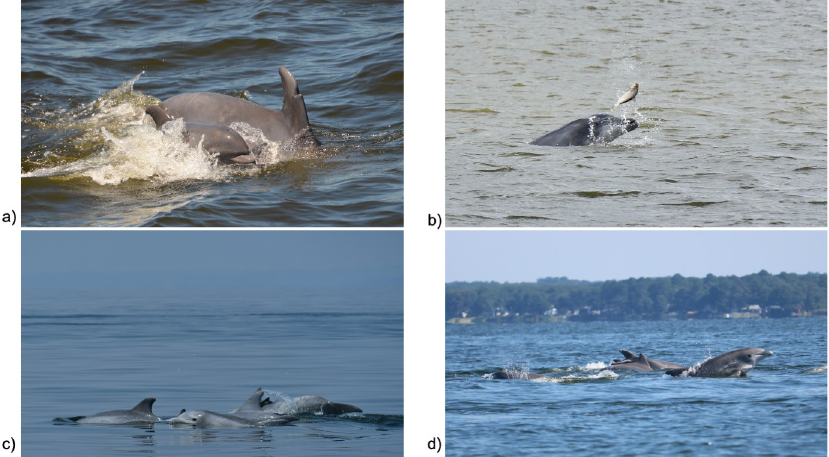
Fig 2. Images submitted into the Chesapeake DolphinWatch application by citizen scientists. a) Photo taken by Toni Knisley of dolphin pod swimming in the Patuxent River (38.30, 76.45) on July 8, 2018. b) Photo taken by Kim Chase Brown of dolphin foraging in the Lower Bay (36.84, -76.55) on October 8, 2018. c) Photo taken by Rhiana Scholz of dolphins swimming in the Kent Narrows channel within the mainstem part of the Bay (38.83, -76.40) on July 3, 2018. d) Photo taken by Tania Richardson Remaly of dolphin pod near Ragged Island (38.15, -76.57) on July 9, 2017.